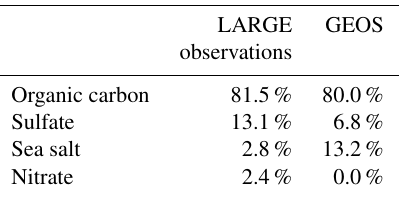
Table 3. The percent contribution of aerosol species to the aerosol mass during the RF9 flight segment from AMS and PILS observa- tions as well as GEOS GOCART. Black carbon is not available from the observations for this flight segment, but the ratio of BC : OC in GEOS is 0 . 07 :